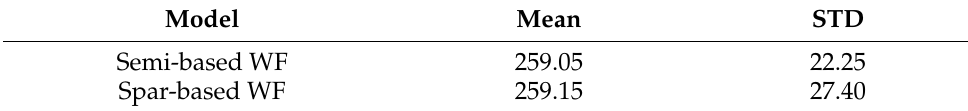
Figure 20. Total output power of offshore wind farms. Table 5. Mean and standard deviation of output wind farm power (MW).